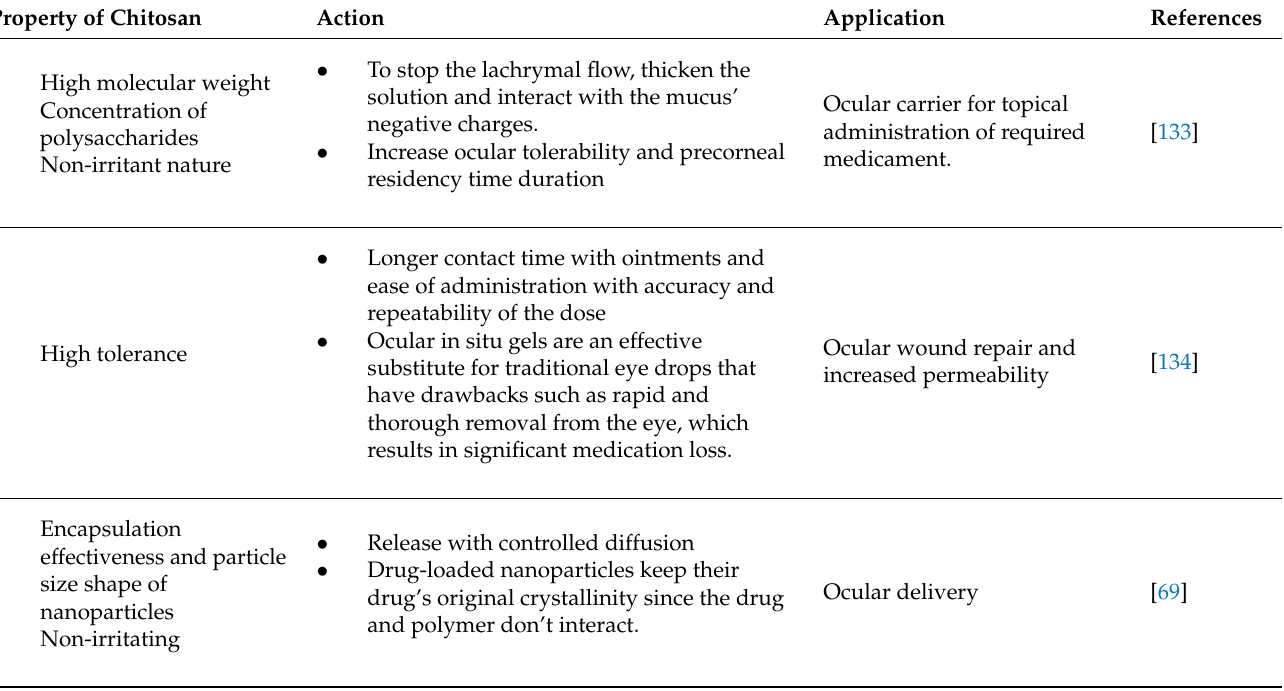
Table 2. A summary of using chitosan for